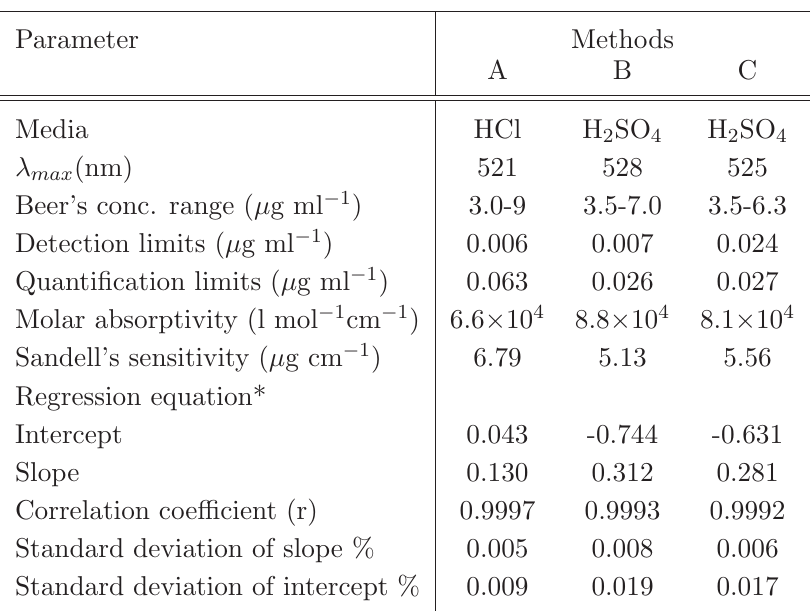
Table 1 Quantitative parameters for the proposed